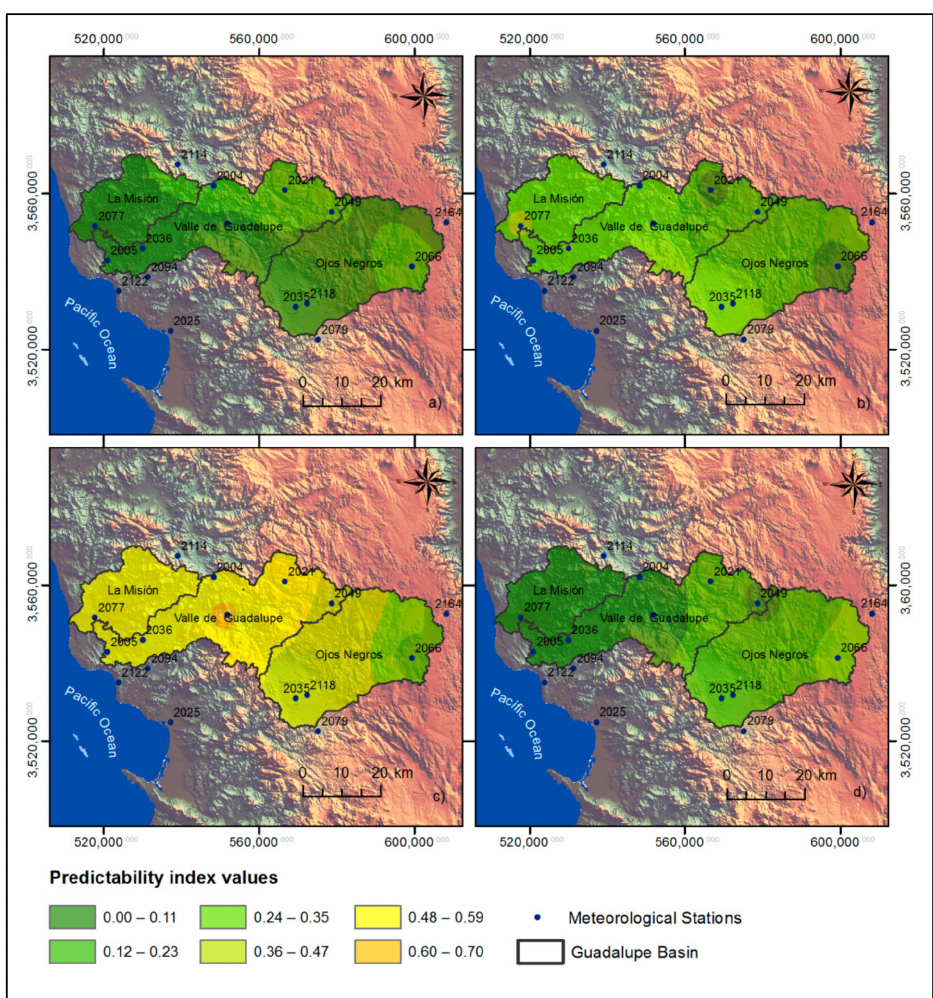
Figure 9. Maps of the predictability index for days with Santa Ana winds for the variables of ( a ) temperature, ( b ) pressure, ( c ) relative humidity, and ( d ) wind